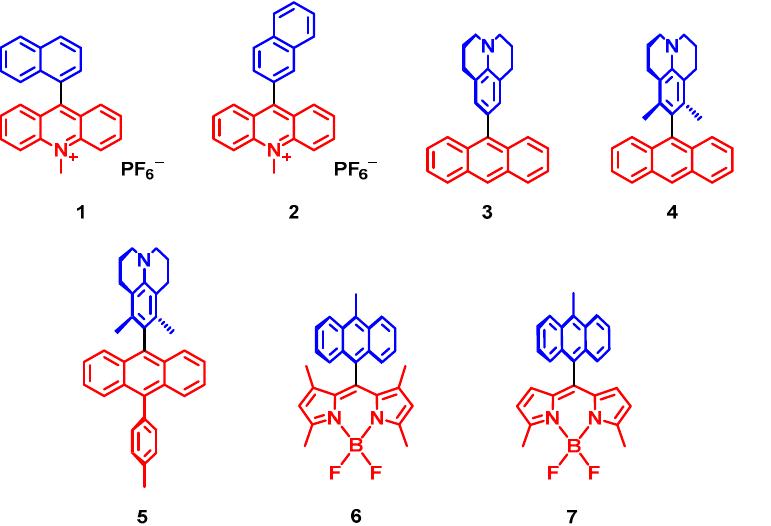
Figure 1. Electron donor/acceptor dyads based on acridinium, anthracene (An) and Bodipy chro- mophores showing SOCT-ISC.